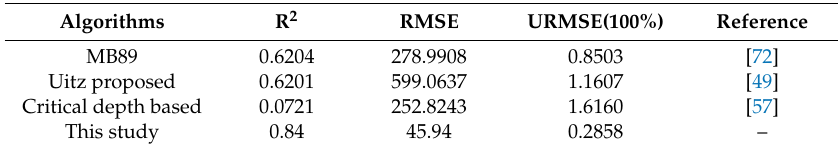
Table 3. Comparison of the performance of the column integrated algal biomass algorithm applied to the in situ dataset from the present